Question: Judging by this figure, is the value going up or going down?
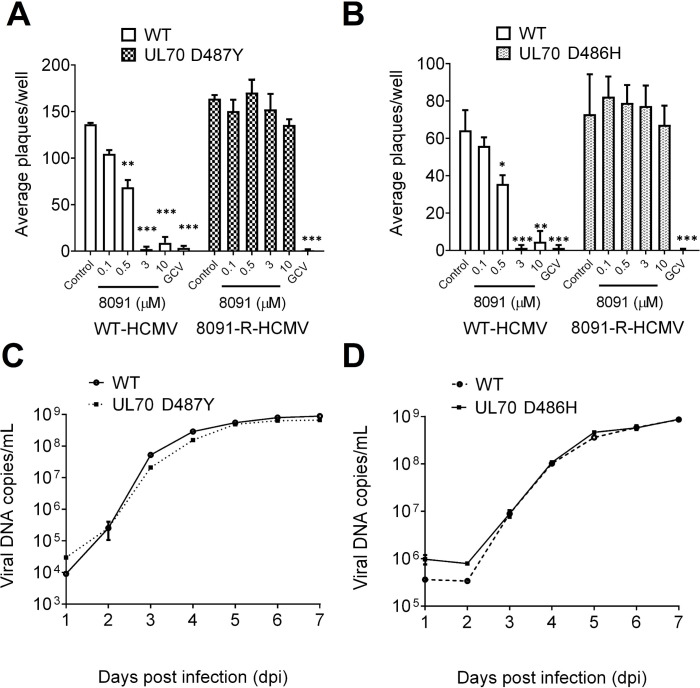
Answer: increasing